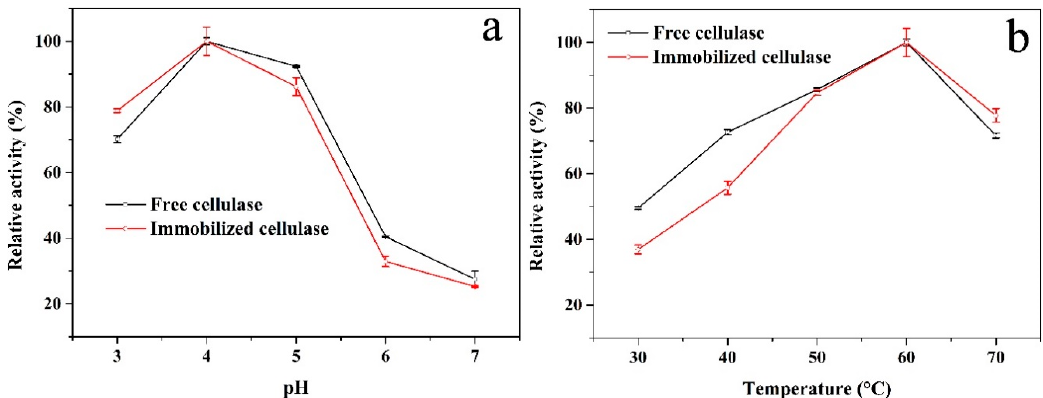
Figure 6. Influences of ( a ) pH and ( b ) temperature on the relative activity of the free (black curve) and immobilized (red curve) cellulase.